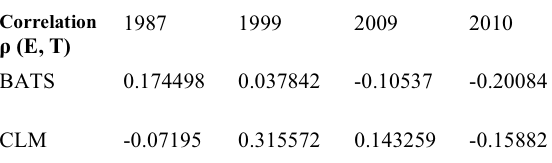
Table 1. Correlation (averaged over central India) between evapotranspiration (mm/day) and temperature (K) ρ (E, T) for El Niño (1987,2009), La Niña (1999,2010) years using BATS and CLM scheme.